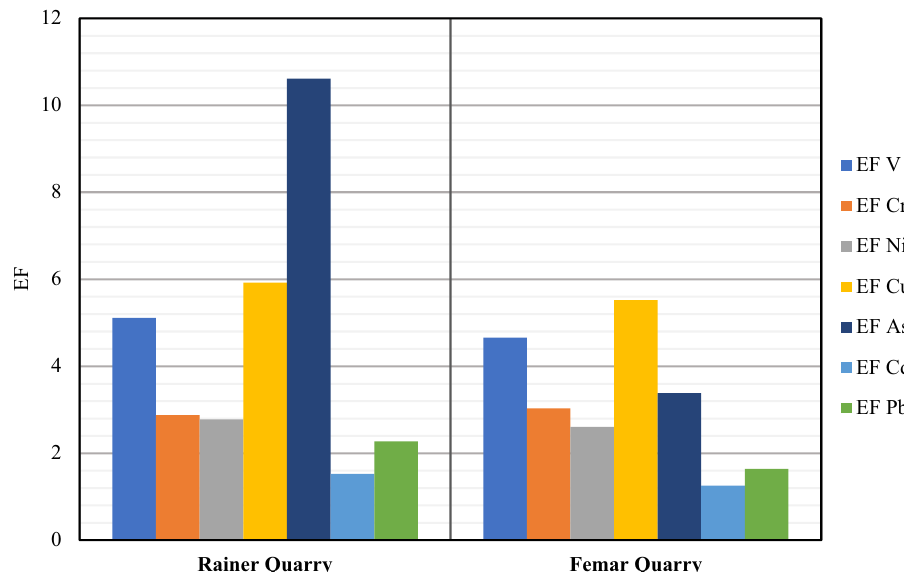
Fig. 9 Enrichment factor (EF) for Rainer and Femar Quarry